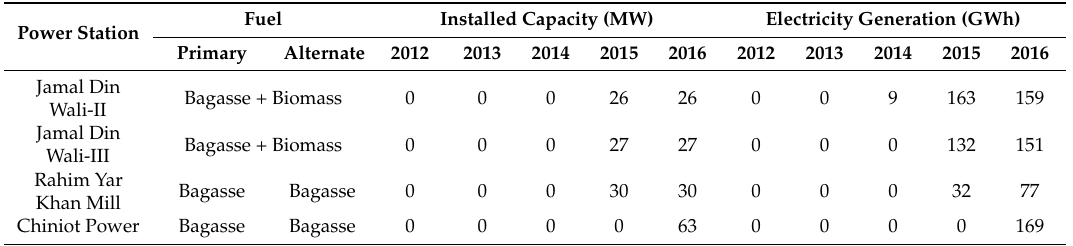
Table 18. Installed capacity (MW) and electricity generation in gigawatt hours (GWh) of bagasse/biomass power stations as of 30 June 2016.